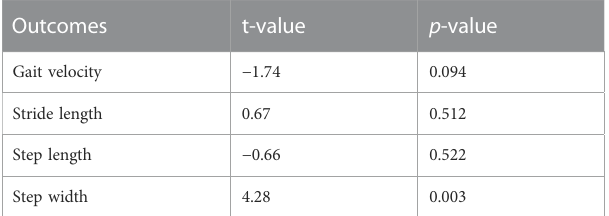
TABLE 5 Publication bias test for gait